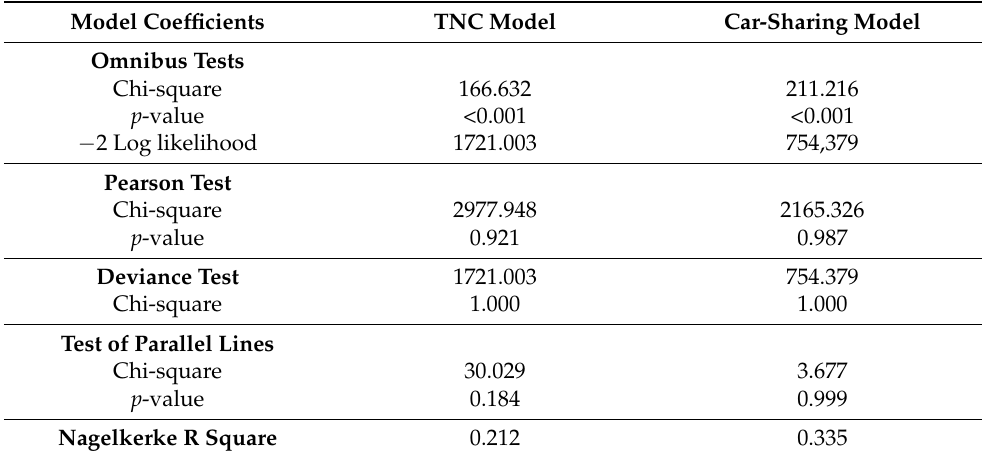
Table 8. The Omnibus tests, the goodness of fit, parallel lines test, and Nagelkerke R2 for the ordinal logistic regression models.